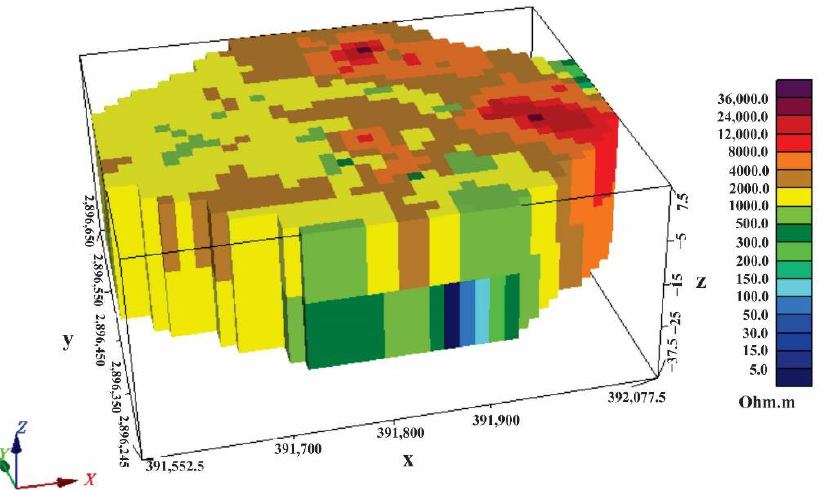
Figure 9. A 3D voxel model of the inverted 2D electrical resistivity profiles (P1 to P11) using Geosoft Oasis Montaj Software version 8.3 that was sliced to horizontal sections at different depths to explain the vertical and horizontal changes in the resistivity values within the investigated site.